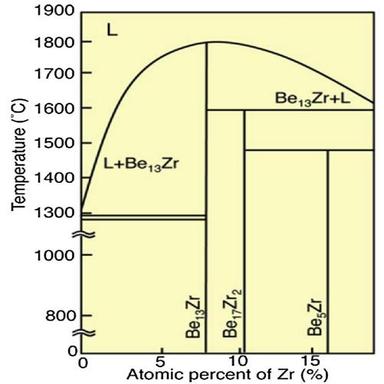
Abridged phase diagram of the Be-Zr binary system.